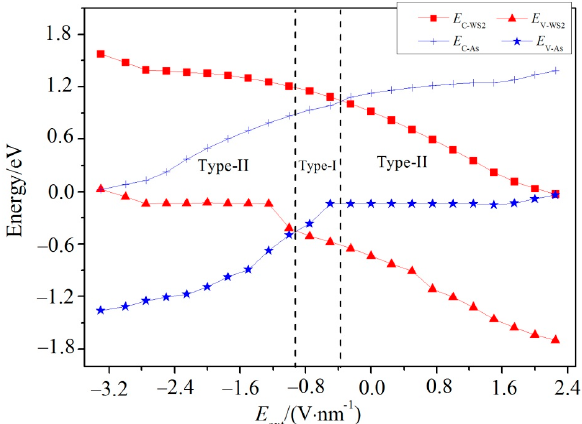
Figure 5. The band edge of the arsenene/WS 2 heterojunction under various electric fields. E C-WS2(As) and E V-WS2(As) are the CBM and VBM of WS 2 (arsenene) in the arsenene/WS 2 heterojunction.